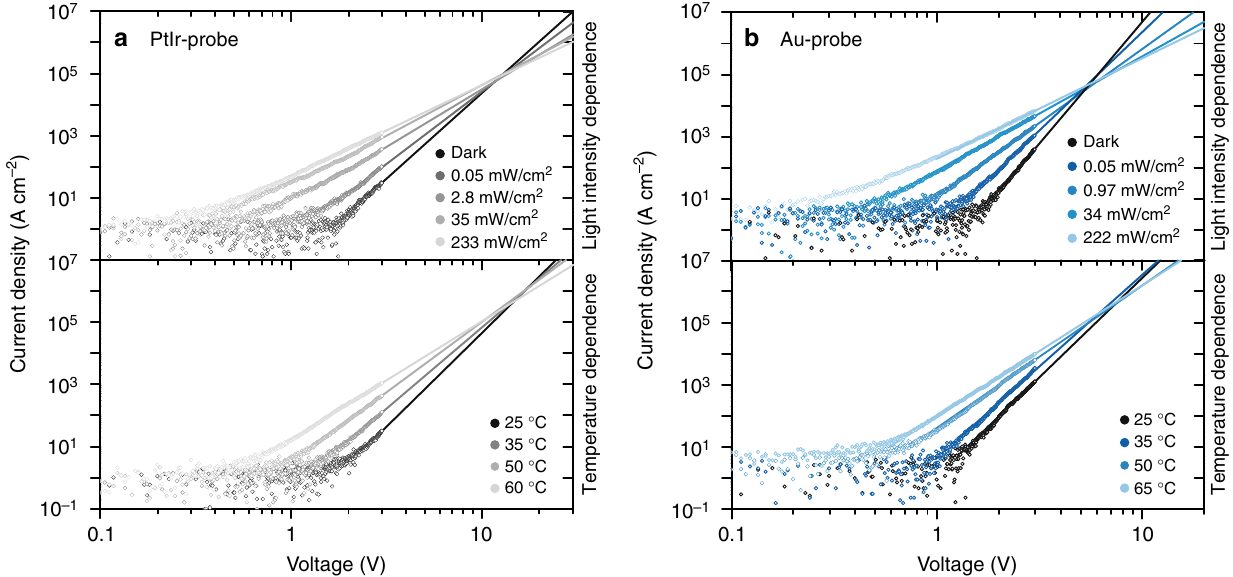
Fig. 4 Charge transport mechanism in BiVO 4 . Temperature and light intensity-dependent JV -characteristics of the FTO/BiVO 4 /probe circuit for PtIr-coated probes ( a ) and Au-coated probes ( b ). For high-bias voltages V s > 0.7 V, the curves show a linear relationship of log( J ) and log( V ), which corresponds to a power law dependence J ∝ V m . Solid lines are power law fi ts to the data in the high-bias regime. The extrapolated JV -characteristics for different intensities (temperatures) intersect at the crossover voltage V c . The power law dependence and the existence of a crossover voltage are signatures of space